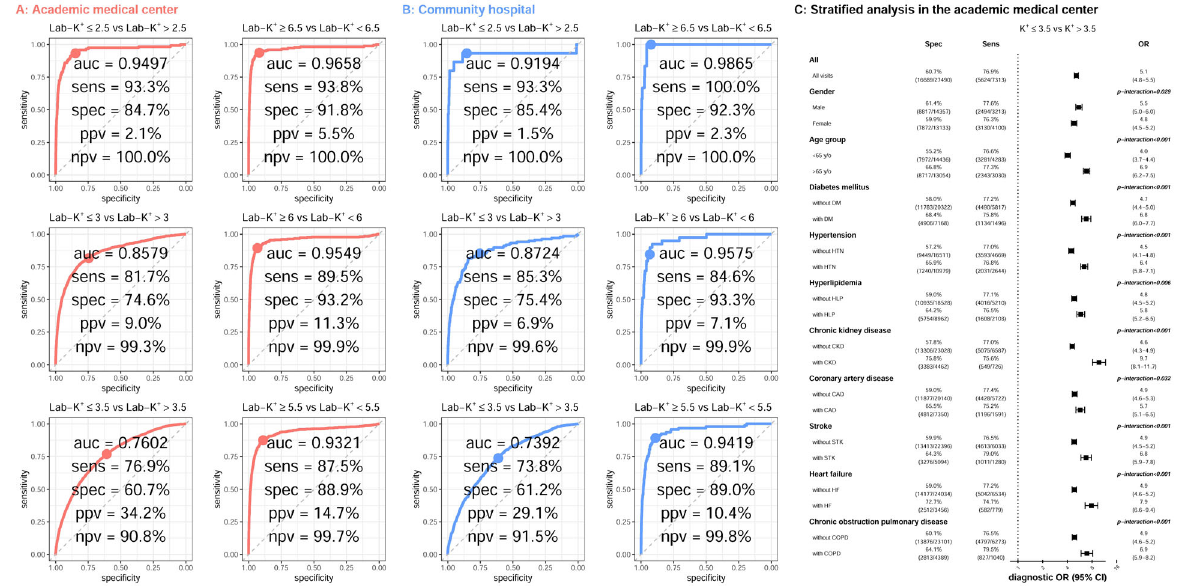
Fig. 2 Performance of ECG-K + for detecting mild to severe hypo/hyperkalemia. The ROC curves for varying degrees of hypo- and hyperkalemia at the academic medical center ( A ) and community hospital ( B ). The cut-of-points for each plot were de fi ned previously, which are the same between the two hospitals. Strati fi ed analyses with the most signi fi cant differences are shown in ( C